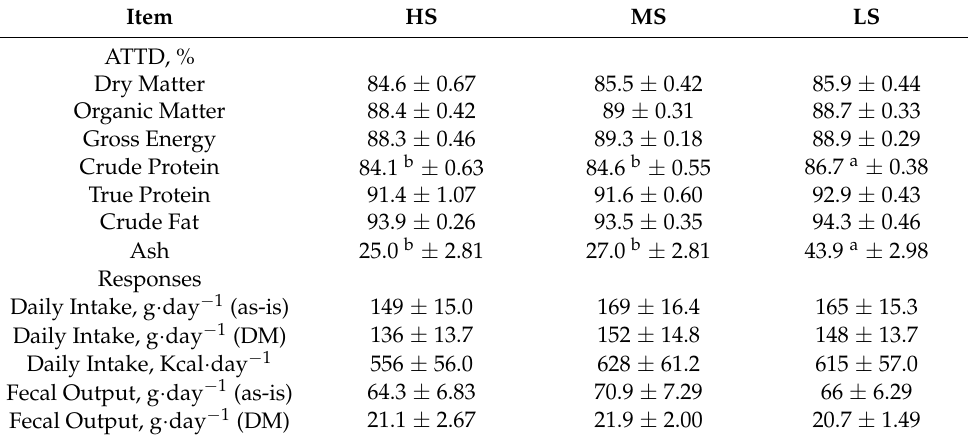
Table 1. Estimated mean (and standard error) total tract digestibility, food intakes and fecal output of dogs ( n = 6 dogs per treatment) subjected to a digestibility study involving high, medium and low shear dietary treatments (HS, MS and LS,